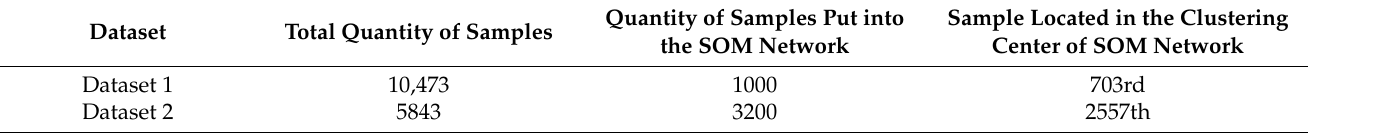
( d ) Figure 16. Distance curves calculated based on the first MCH: ( a ) Dataset 1, ( c ) Dataset 2; distance curves calculated based on the OHS: ( b ) Dataset 1, ( d ) Dataset 2. Table 9. Quantitative comparison of early degradation detection results. Dataset